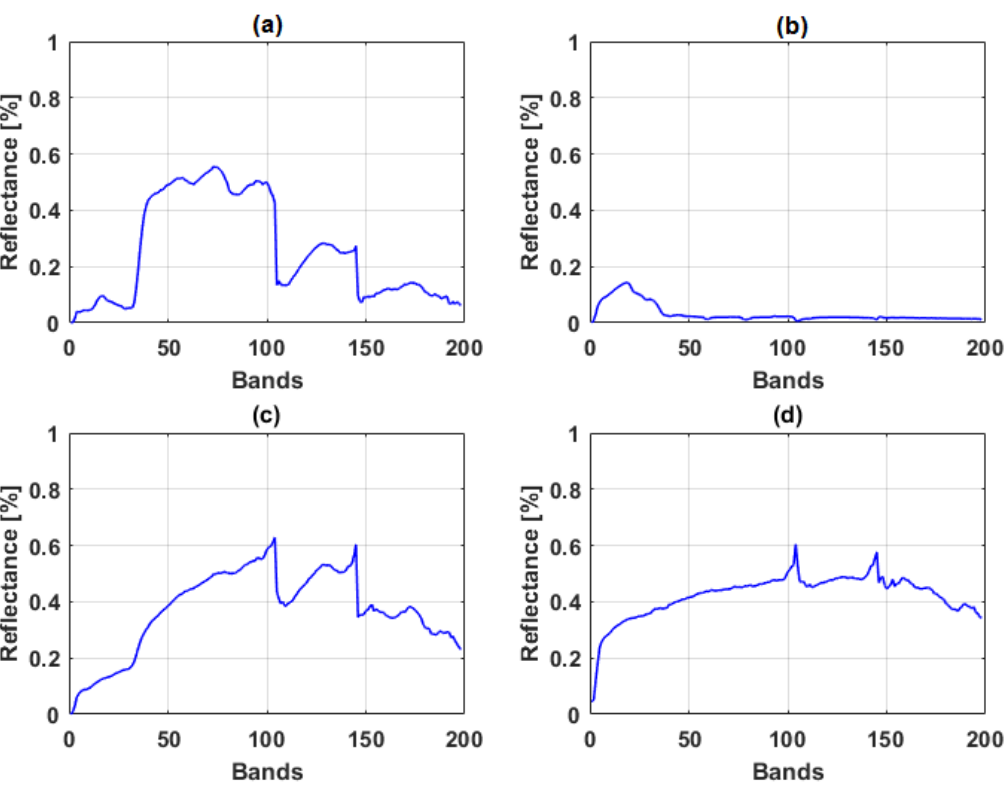
Figure 3. Spectral reflectance of endmembers of the Jasper Ridge data ( a ) tree; ( b ) water; ( c ) soil; ( d )